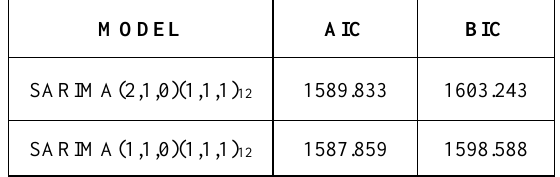
Table 1 . Comparison of SARIMA models. Figure 7 presents the forecasted data generated by the model. The computed MAPE and RMSE are 13.26% and 361.3796, respectively which tells us that SARIMA(1,1,0)(1,1,1) 12 is a good model for the cumulative EVI anomalies in the Philippines.